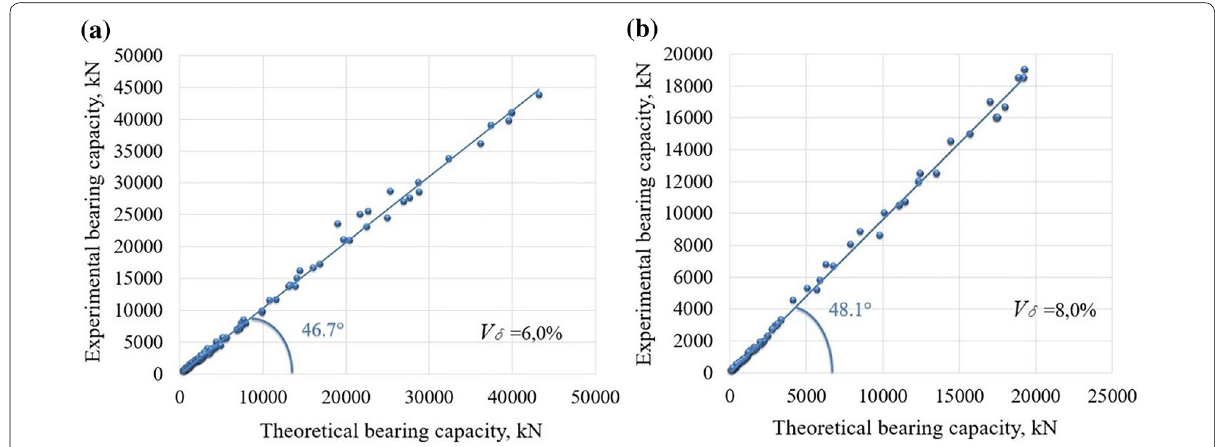
Fig. 6 Comparison of the bearing capacity theoretical values centrally ( a ) and eccentrically ( b ) compressed CFTC with experimental